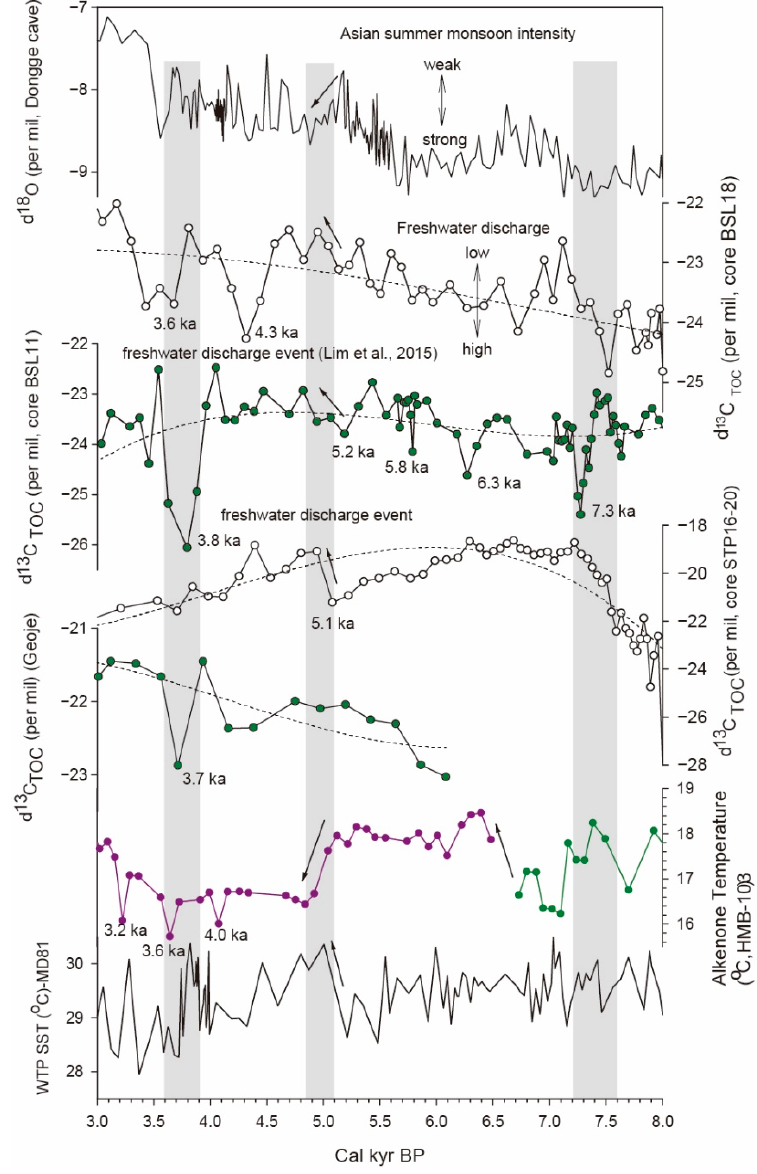
Figure 6. Comparison of δ 13 C TOC curves from the Deukryang area cores STP16-20 [11], BSL18 [4], and BSL11 (this study) with the Asian monsoon index [30], sea surface temperature data [31], and alkenone temperature [29].